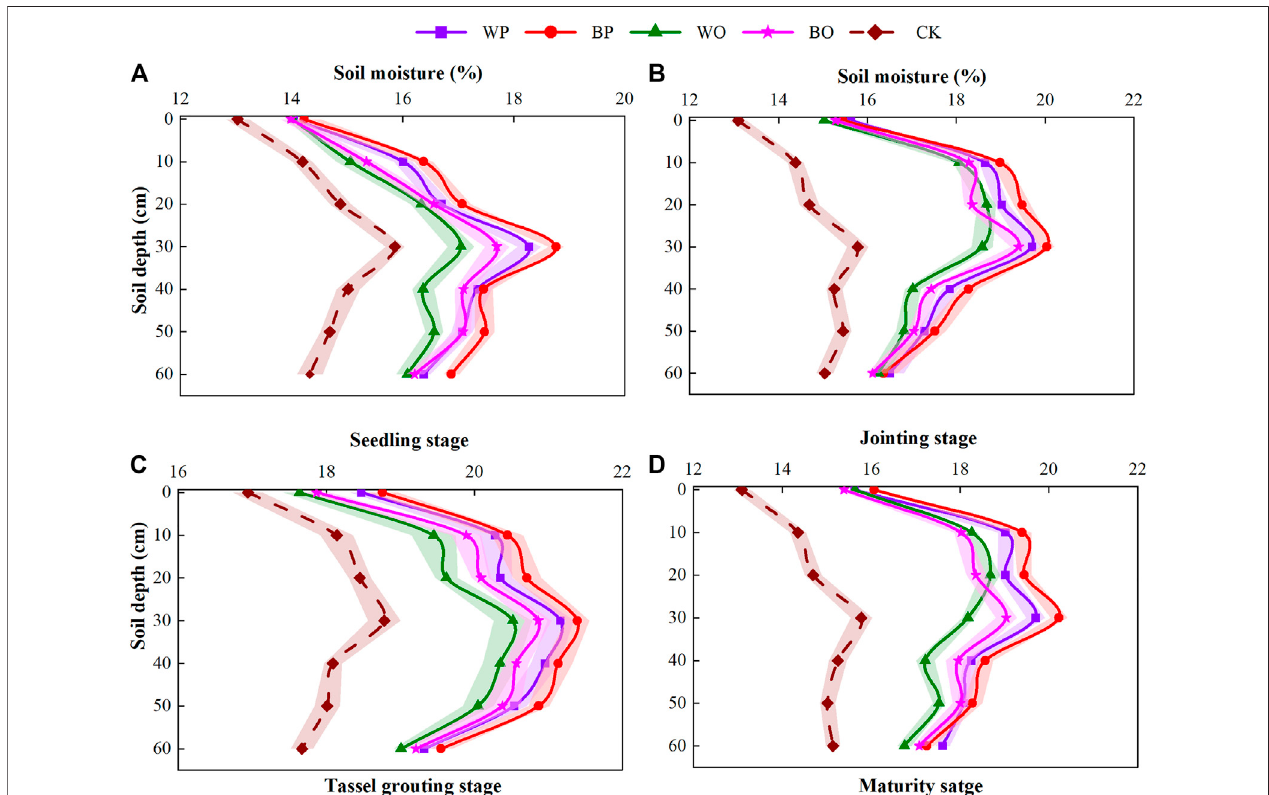
FIGURE 4 | The vertical changes of soil water content in 0 – 60 cm soil layer under different mulching fi lms of Seedling stage (A) , Jointing stage (B) , Tassel grouting stage (C) and Maturity stage (D) .